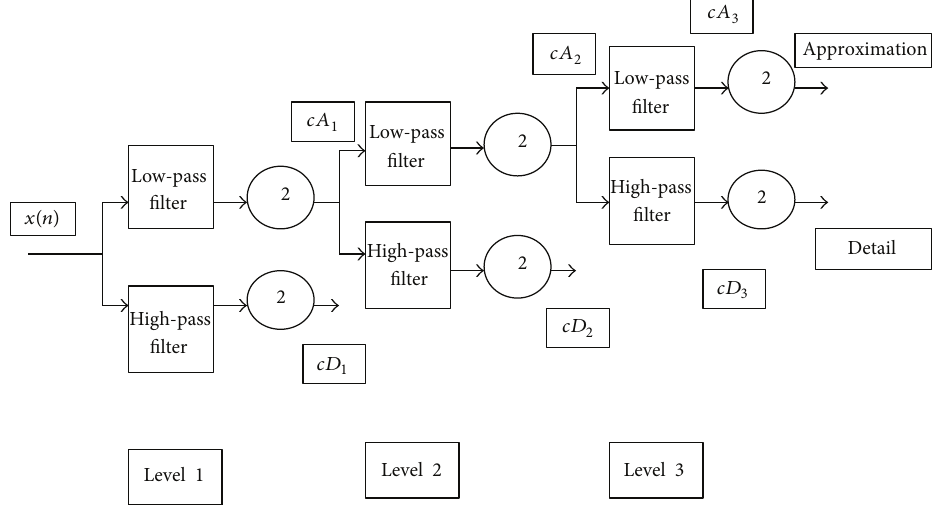
Figure 1: Diagram of multiresolution analysis of signal 𝑥 𝑖 (𝑡)